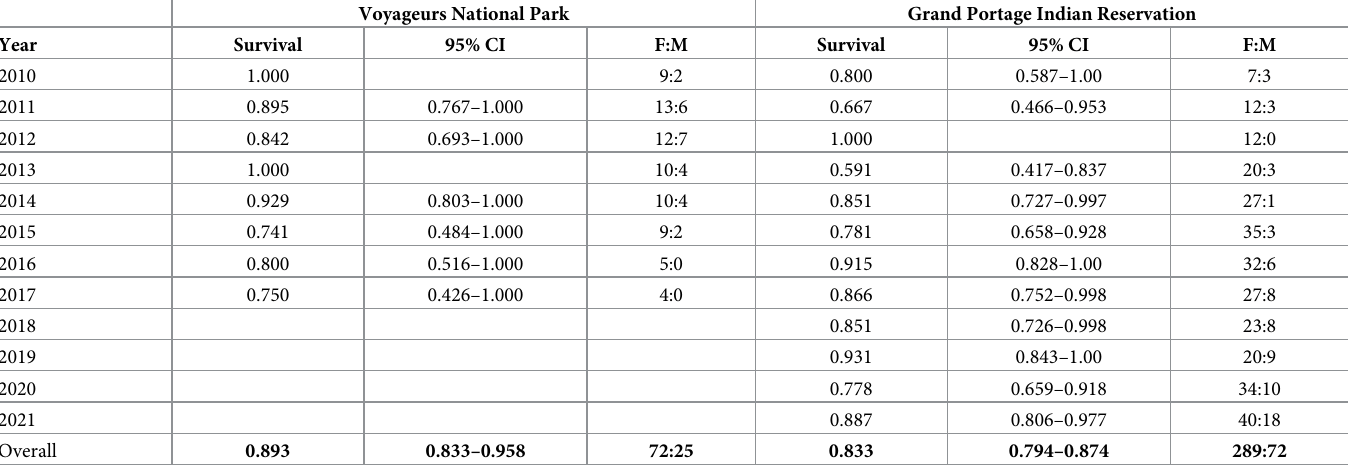
Table 3. Adult moose survival estimates for Voyageurs National Park and Grand Portage Indian Reservation. Estimates of annual survival and sex-ratios of collared adult moose in Voyageurs National Park and Grand Portage Indian Reservation, MN, USA, 2010–2021.